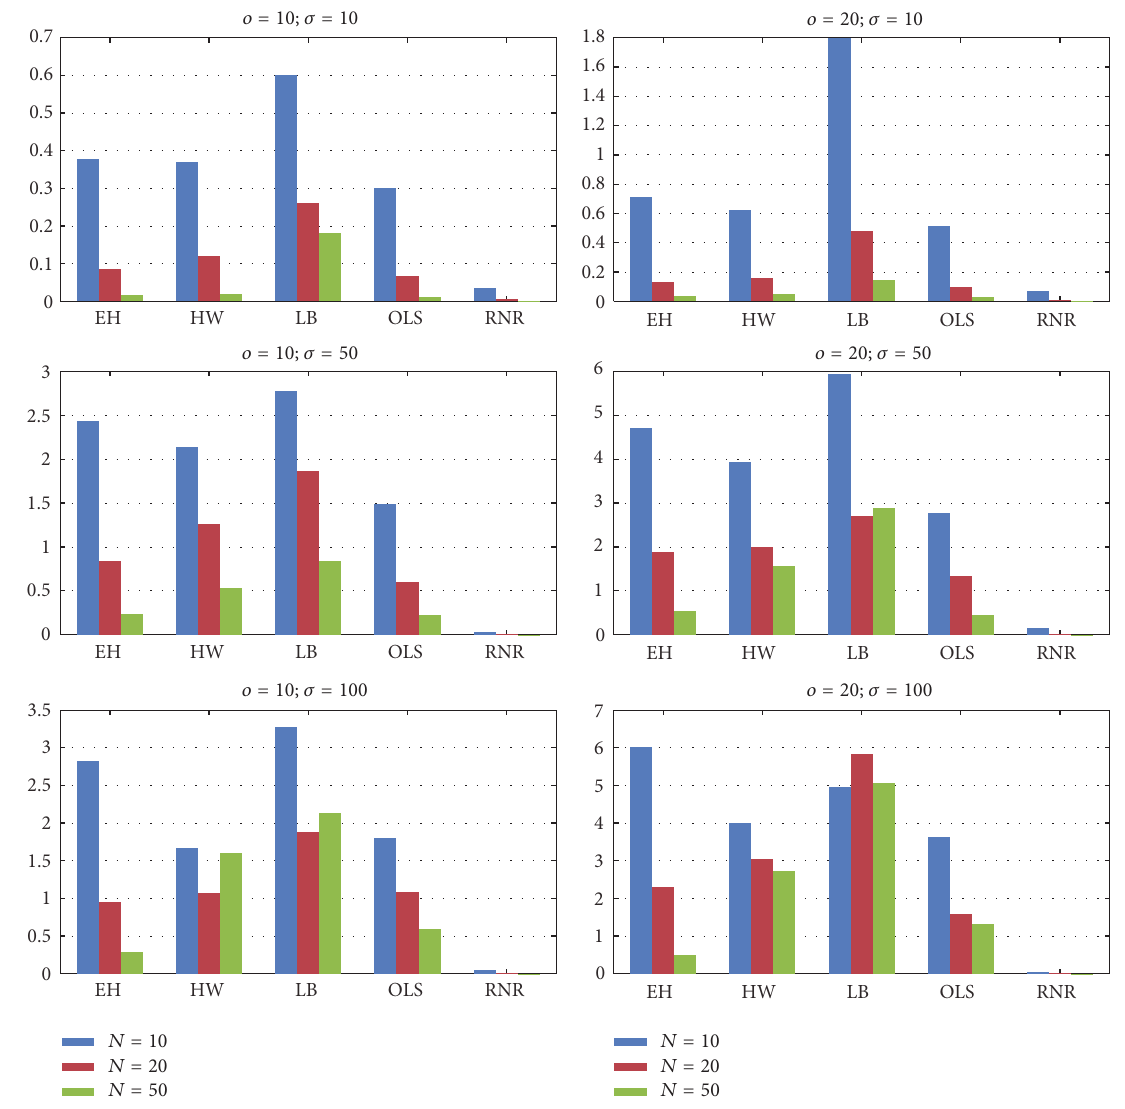
Figure 5: Normalized mean square error of 𝑉 max for different